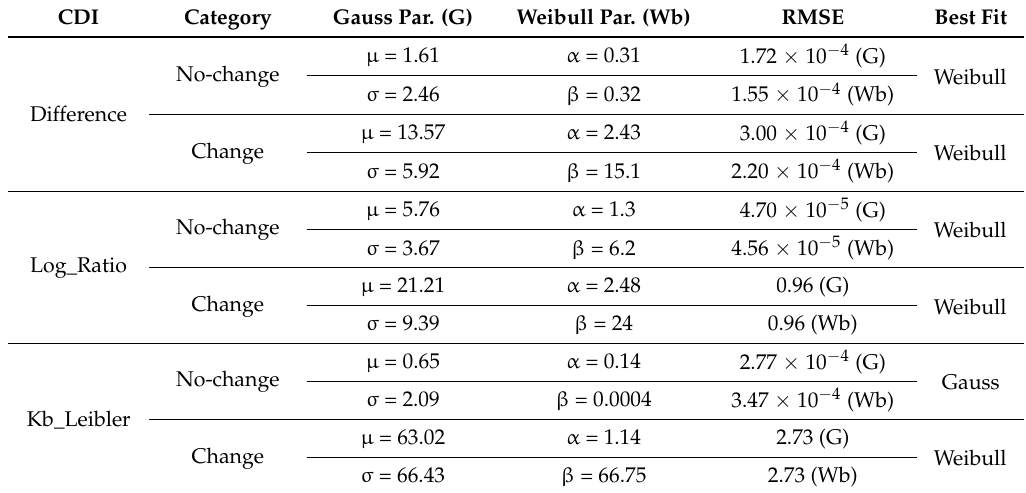
Table 6. DS2, PDF Parameters.